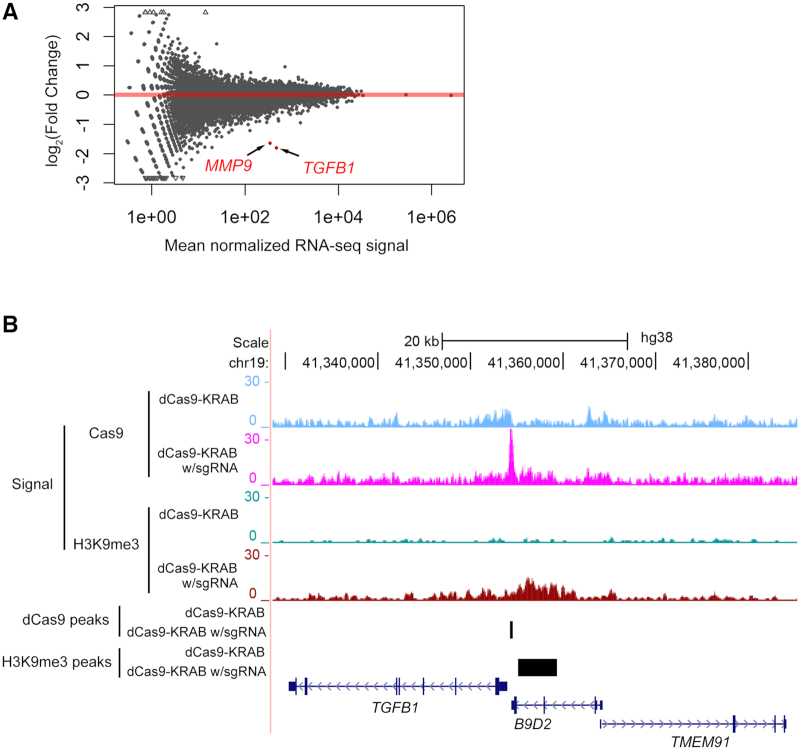
RNA-seq and ChIP-seq indicate that the CRISPRi targeting rs1800469 regulates the expression of TGFB1 and tightly associates with a region specified by the sgRNA target sequence. (A) TGFB1 was most highly repressed by the CRISPRi targeting rs1800469. RNA-seq was performed using RNAs from H441 cells infected with the lentiviral CRISPRi expressing both dCas9-KRAB and sgRNA targeting the region with SNP rs1800469 and the control (dCas9-KRAB only). Three replicates were used for each group. Red points represent genes with log2 fold change ≥1 or ≤−1; padj <0.1. (B) ChIP-seq data using H441 cells indicates that the CRISPRi targeting rs1800469 bound to a region that matches to our gRNA target sequence. A histone repressive mark (H3k9me3) was adjacently associated with the binding of the CRISPRi targeting rs1800469. The analyses were performed twice independently (see Supplementary Figure S3).